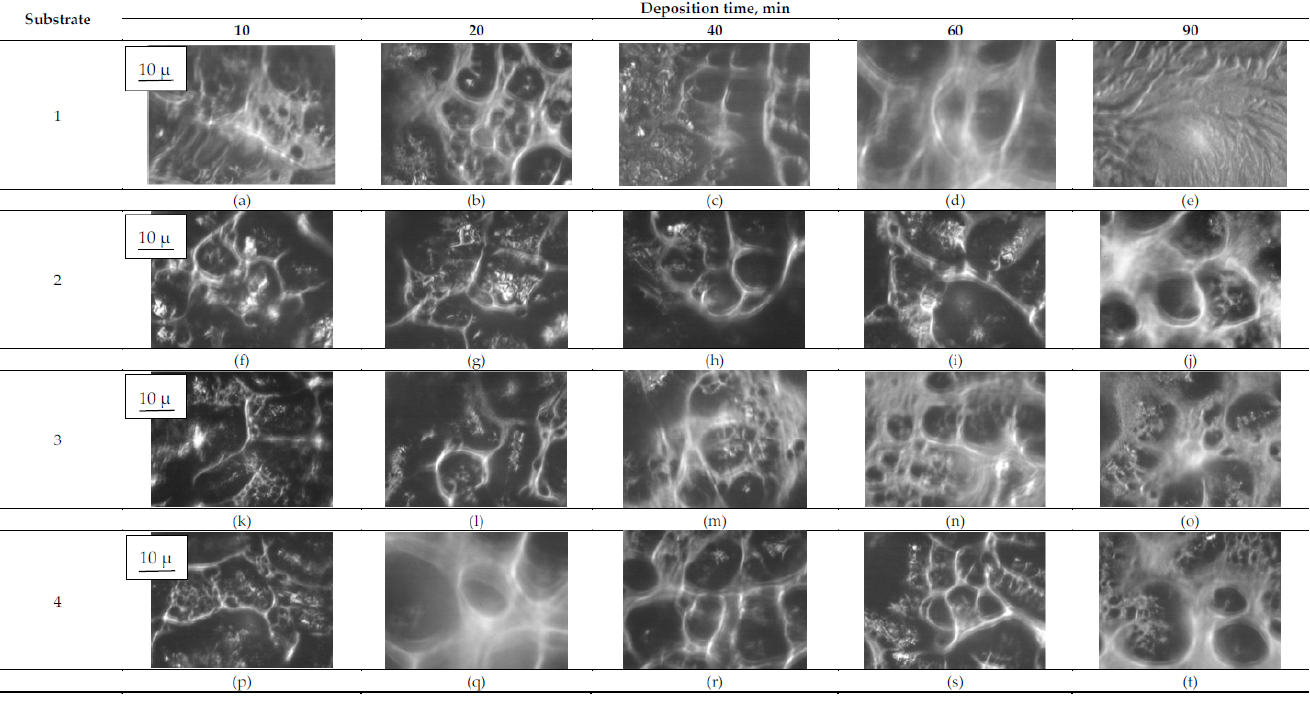
Figure 3. Optical image of sulfacyl sodium on four types of substrates with different deposition times.